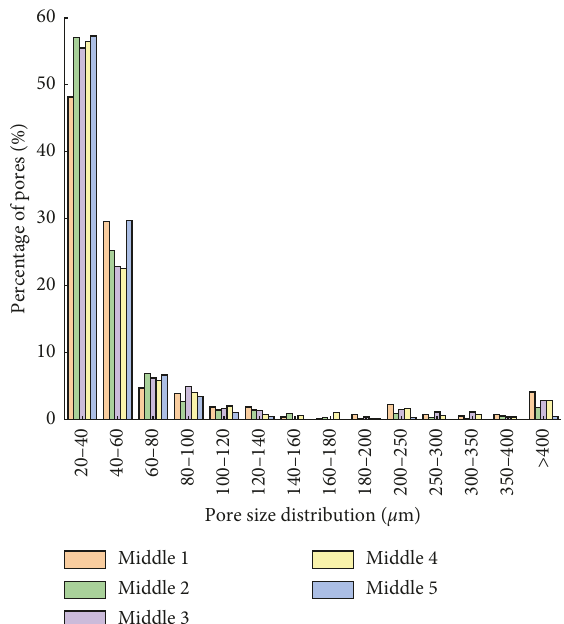
Figure 5: Pore size distribution of the aerated concrete block (middle).